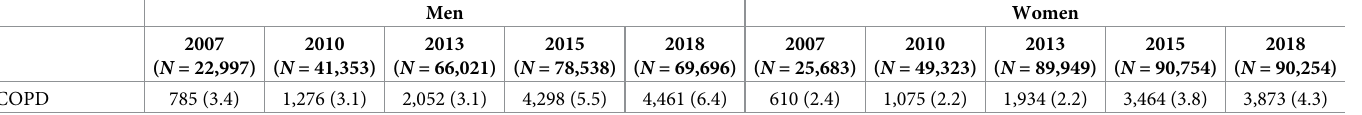
in S3 Text ). The downward trend was evident across all educational groups before 2010, but after 2010, it appeared much less obvious in those without college or university education ( Table B in S3 Text ). Similarly, across different occupations, the trend was not uniform, with the most striking decreasing trend observed among service providers (59.2% [95% CI: 54.0 to 64.4] to 46.4% [95% CI: 42.7 to 50.1]; 2.0% annual rate of decrease; p for trend < 0.001; p for difference = 0.003) and professional occupations (53.0% [95% CI: 49.0 to 57.1] to 42.6% [95% CI: 39.9 to 45.3]; 1.8% annual rate of decrease; p for trend < 0.001; p for deference < 0.01). Among men who were unemployed or students, there was a significant increasing trend (37.7% to 47.7%; 1.9% annual rate of increase; p for trend 0.006; Table B in S3 Text ). Across all surveys, men born in the 1960s consistently had the highest smoking prevalence compared with men born in other decades. In contrasting to a decreasing trend among men born before 1980, a significant increasing trend in the prevalence of current smoking among men born after 1980 was observed ( p for trend < 0.001 for 1980s and p for difference = 0.004), with a considerable increase in rural men born in the 1990s (from 40.2% [95% CI: 34.0 to 46.4] in 2010 to 52.1% [95% CI: 45.7 to 58.5] in 2018; p for trend = 0.007), especially before 2015 ( Fig 2 and Tables B and G in S3 Text ).